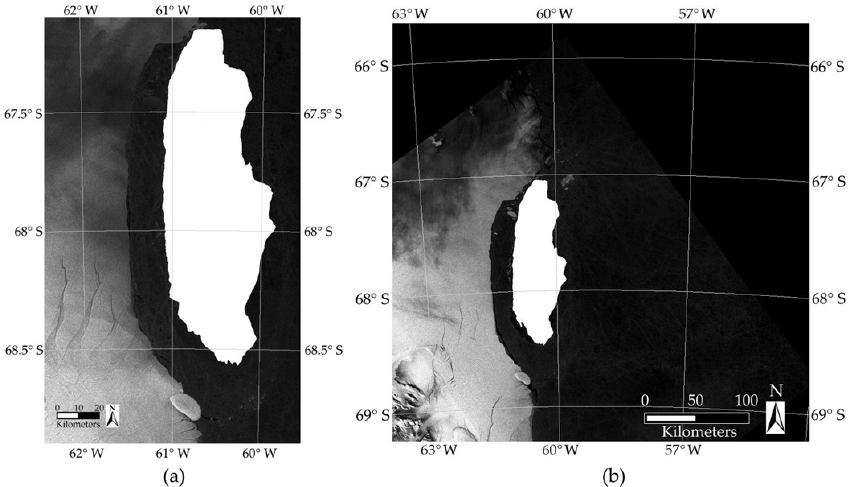
Figure 4. Segmentation results obtained by the proposed scheme: ( a ) Image of 13 December 2017, and ( b ) Image of 18 January 2018. The detected A-68A object is displayed in the input SAR scenes. The detected shape is homogeneous and without spurious